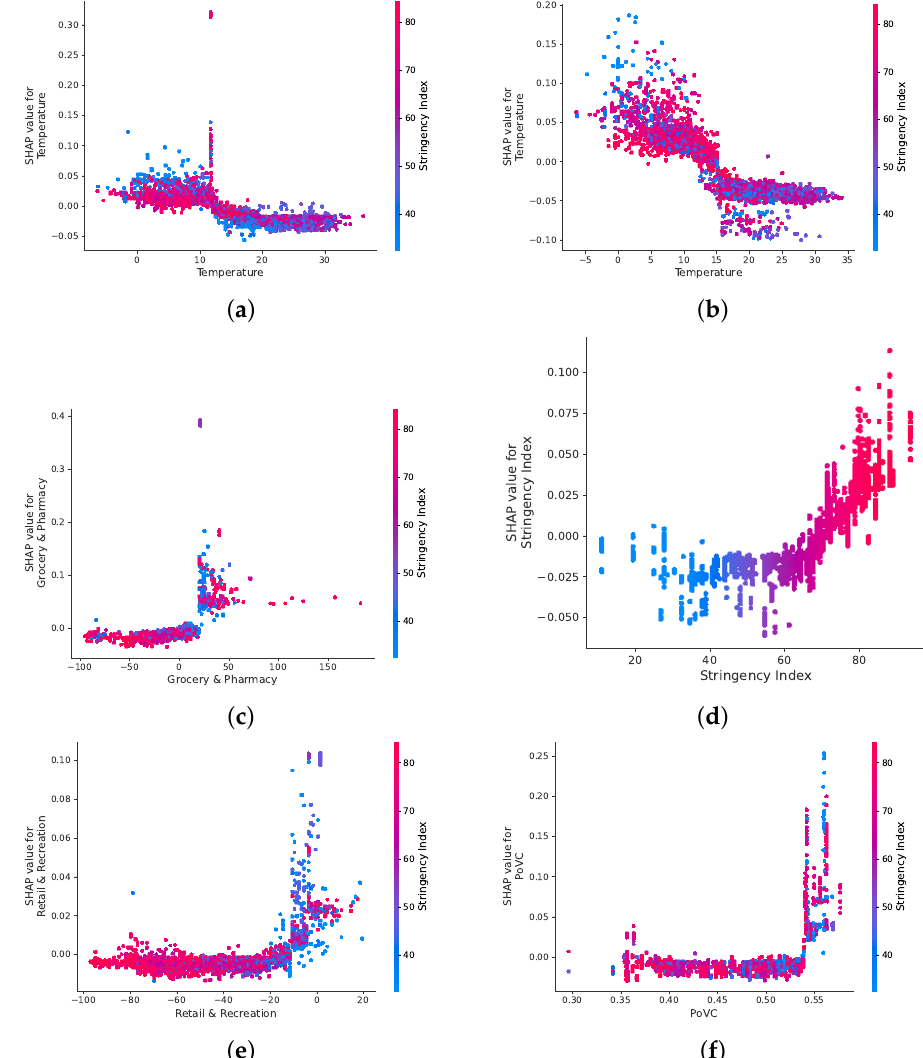
Figure 5. SHAP dependence plots for feature understanding. The first column represents SHAP dependence plots for the 3 most important features for the cases model, while the second for the one predicting deaths. SHAP dependence plots depict the contribution of each features value to the models prediction. All graphs interact with the Government Response Stringency Index. ( a ) Tem- perature; ( b ) temperature; ( c ) grocery and pharmacy; ( d ) stringency index; ( e ) retail and recreation; ( f ) percentage of vegetation